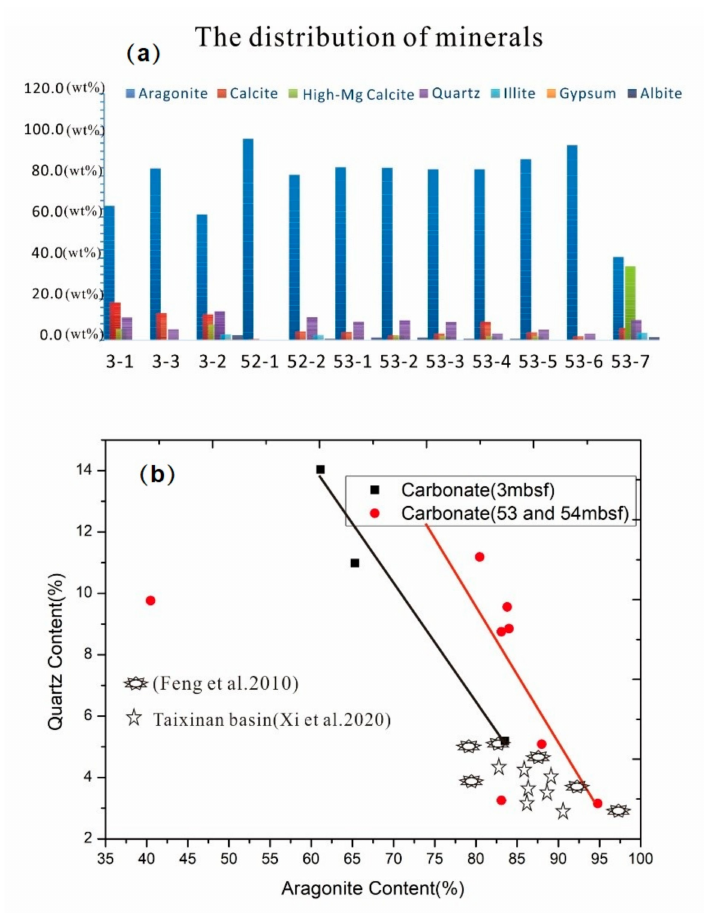
Figure 8. ( a ) Mineral distributions of all carbonate samples. ( b ) Plot of the aragonite content and the quartz